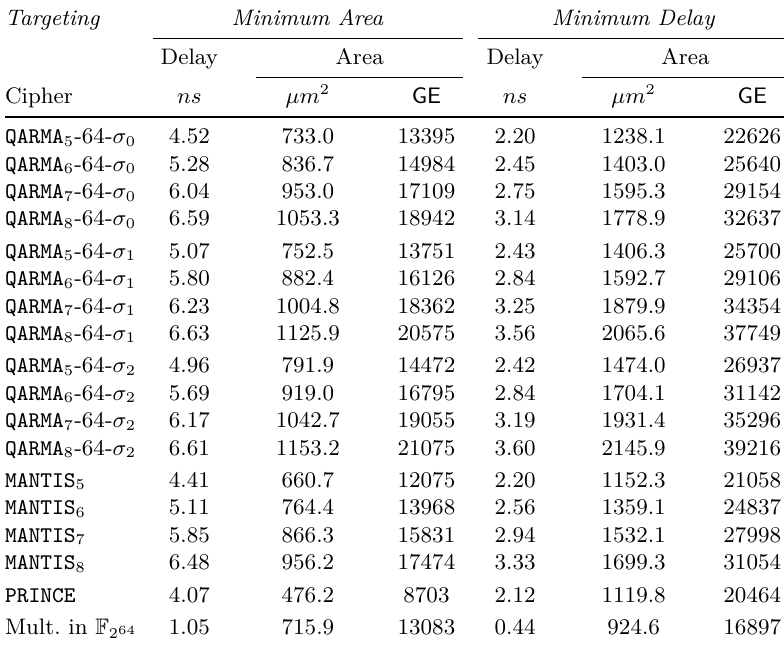
Table 8: Delay and Area for QARMA -64, MANTIS and PRINCE , all fully unrolled Targeting Minimum Area Minimum Delay Delay Area Delay Area Cipher ns µm 2 GE ns µm 2 GE QARMA 5 -64- σ 0 733.0